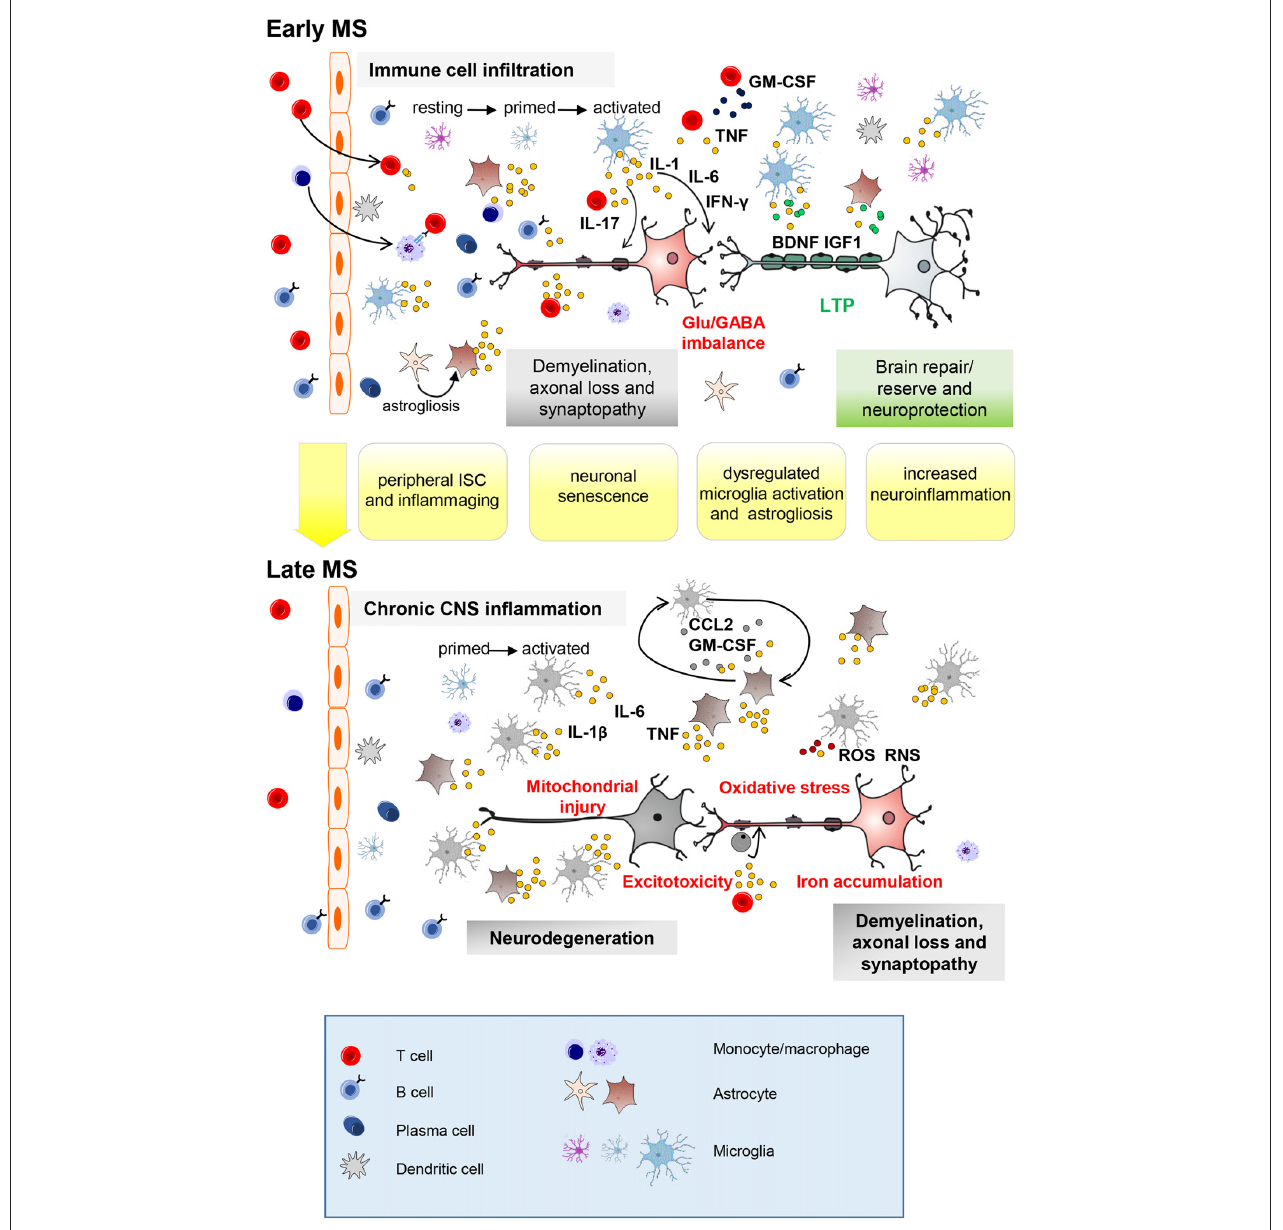
FIGURE 1 | Key neuroinflammatory processes occurring in the central nervous system (CNS) of multiple sclerosis (MS) patients influenced by aging. Immune cell infiltration from the periphery, mainly through the blood–brain barrier, is a prominent feature of early-stage MS (top panel). Peripheral innate and adaptive immune cells, along with activated CNS-resident microglia and astrocytes, promote demyelination, axonal injury and synaptopathy mainly through action of soluble inflammatory (IL-1 β , Interleukin-1 β ; TNF, tumor necrosis factor; IFN- γ , interferon- γ ; IL-17, interleukin-17) and neurotoxic mediators. Neuronal damage can be completely or partly resolved due to remyelination, resolution of inflammation and neuroprotective/reparative mechanisms (growth factors). Furthermore, additional mechanisms, from local synaptic plasticity to brain rewiring, intervene to functionally compensate synaptic loss (long-term potentiation, LTP). With advancing years, premature aging processes such as peripheral immunosenescence (ISC) and inflammaging may lead to age-related changes in the blood. Neuronal senescence and unusual microglia (primed) activation as well as astrogliosis (IL-1 β ; IL-6; TNF; granulocyte–macrophage colony-stimulating factor, GM-CSF; CC-chemokine ligand 2, CCL2) might contribute at exacerbating MS neuroinflammatory processes (synaptopathy, impaired synaptic plasticity, reduced production of brain derived neurotrophic factor (BDNF) and insuline-like growth factor (IGF-1)). Later on (bottom panel), immune cell infiltration wanes, perhaps due to adaptive immune cell exhaustion from chronic antigen exposure. However, chronic CNS-intrinsic inflammation, and other processes influenced by age (such as oxidative stress, mitochondrial injury, iron accumulation and excitotoxicity) might contribute at exacerbating early pathological processes leading to neurodegeneration. Further microglial recruitment and activation might be induced by interaction with astrocytes releasing CCL2 and GM-CSF as occur during aging. Astrocytes can prevent remyelination at sites of neuroaxonal injury by inhibiting progenitor cells from developing into mature oligodendrocyte cells (ODCs). RNS, reactive nitrogen species; ROS, reactive oxygen